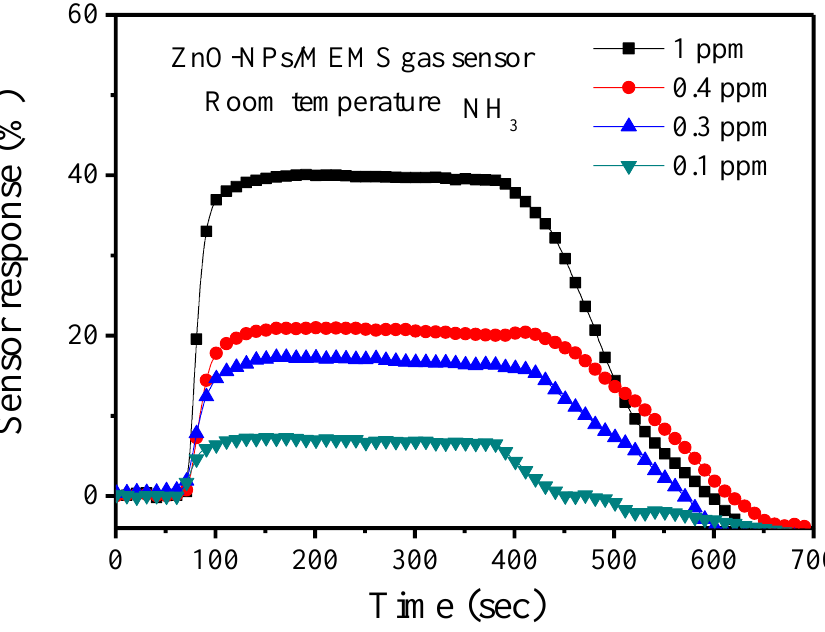
Figure 5. Sensor response for the ZnO-NPs/MEMS NH3 sensor at room temperature at various concentrations.